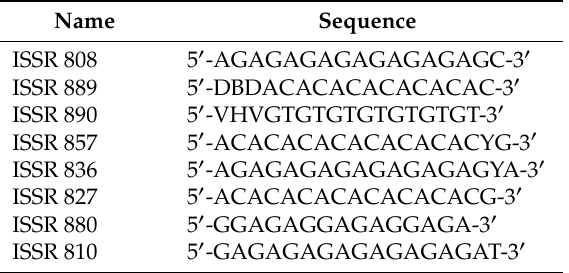
Table 2. Sequences of the inter simple sequence repeat (ISSR) primers used in this study. Name